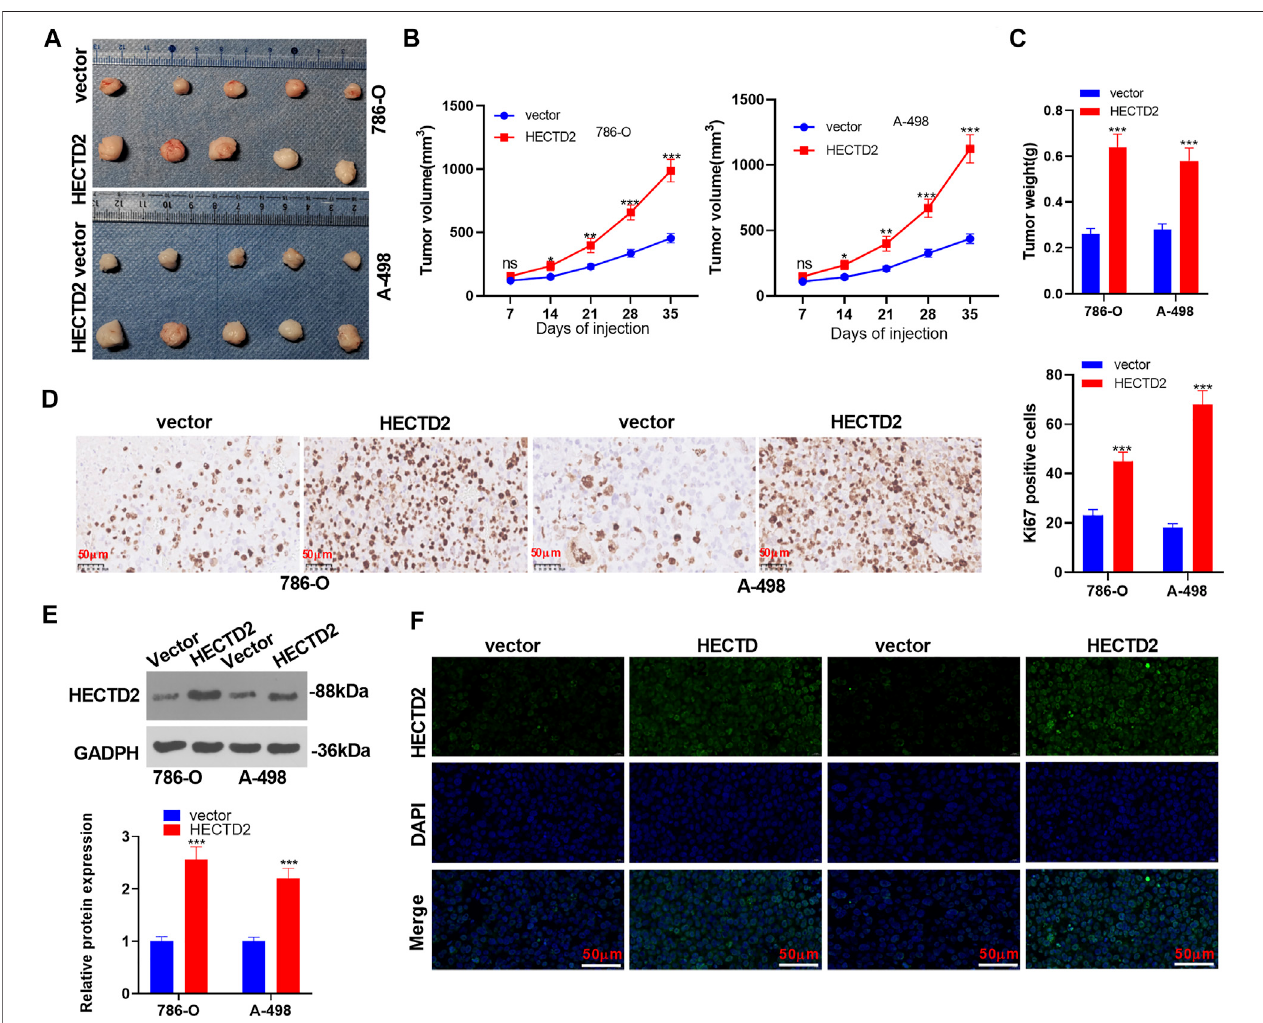
FIGURE3| In fl uencesofoverexpressingHECTD2onthemalignantphenotypesofRCC invivo .TheHECTD2overexpressionmodelwasestablishedin786-Oand A-498 cells, which were then used for constructing xenografted tumor model in nude mice. The mice were sacri fi ced at the 35th day after cell transplantation. (A – C) : Tumorvolumeandweight. (D) :ThenumberofKi67-positivecellsin786-OandA-498cellswasevaluatedbyIHC. (E) :Thepro fi leofHECTD2intheformedtumortissues was tested by WB. (F) : The fl uorescence intensity of HECTD2 was tested by tissue immuno fl uorescence. ns p > 0.05, * p < 0.05, ** p < 0.01, *** p < 0.001. N (cid:2) 5. Scale bar (cid:2) 50 μ